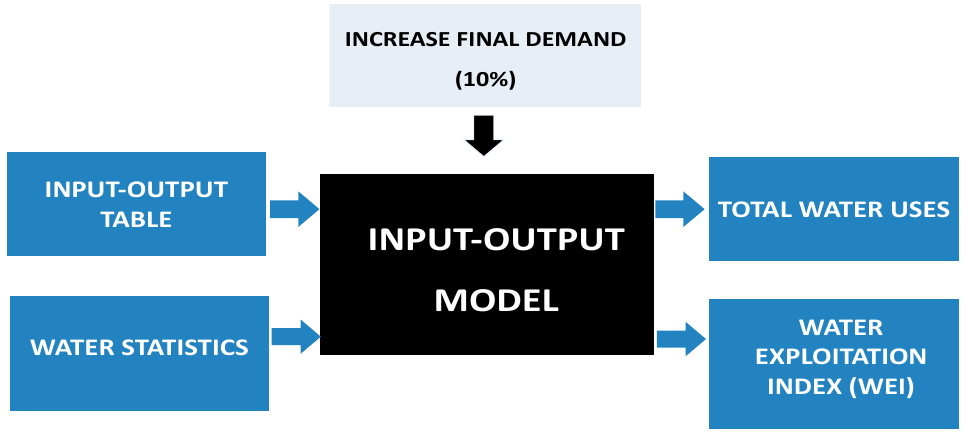
Figure 2. Flowchart of the method used.